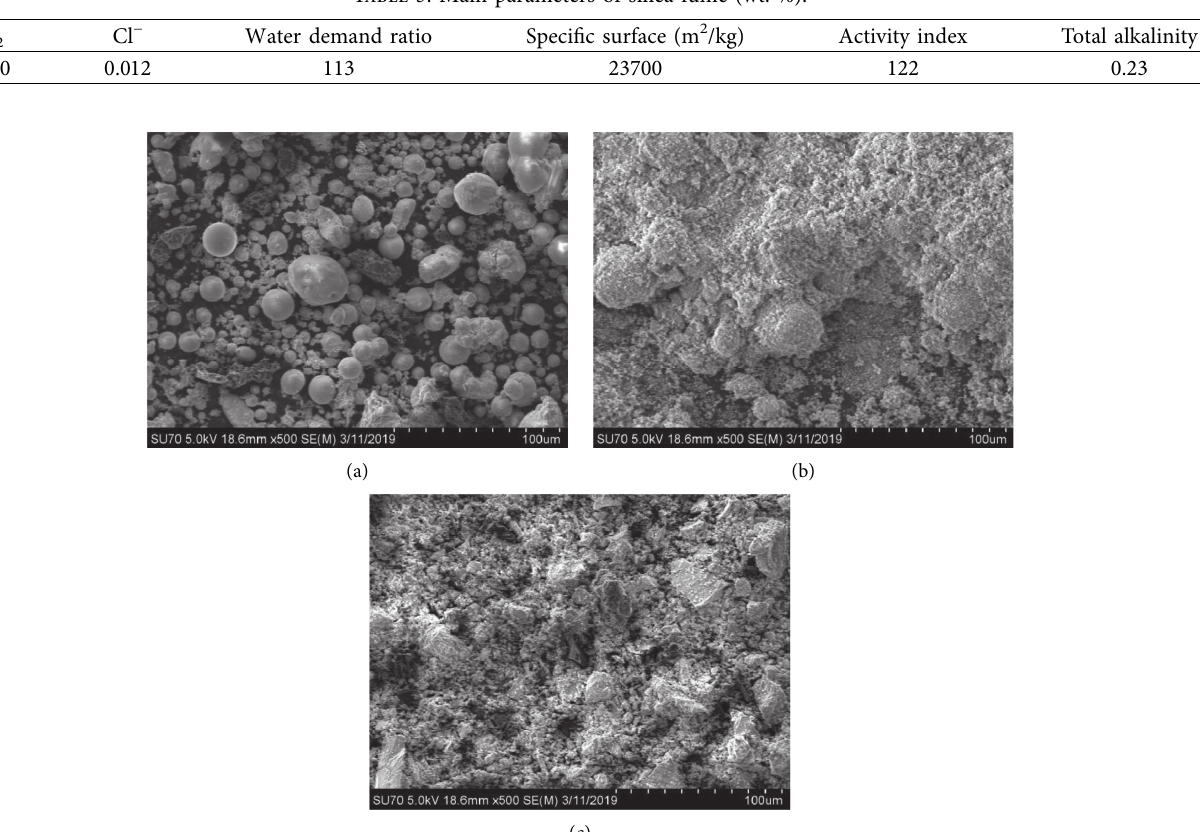
Table 3: Main parameters of silica fume (wt. %).